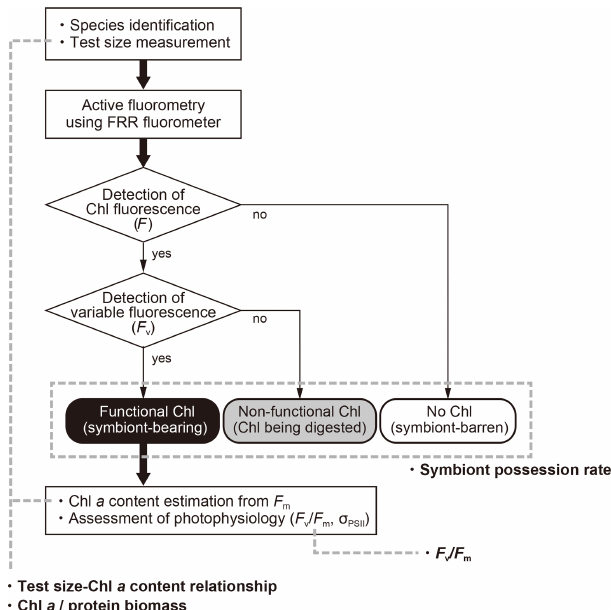
Figure 5. Summary of categorization of intracellular chlorophyll. The functionality of chlorophyll indicates the presence of sym- bionts. The numbers of specimens for the three categories are rep- resented in parentheses as follows: functional chlorophyll / non- functional chlorophyll/no chlorophyll. The percentage of functional chlorophyll is essentially the same as the symbiont possession rate used as a variable to characterize photosymbiosis (see text for de-